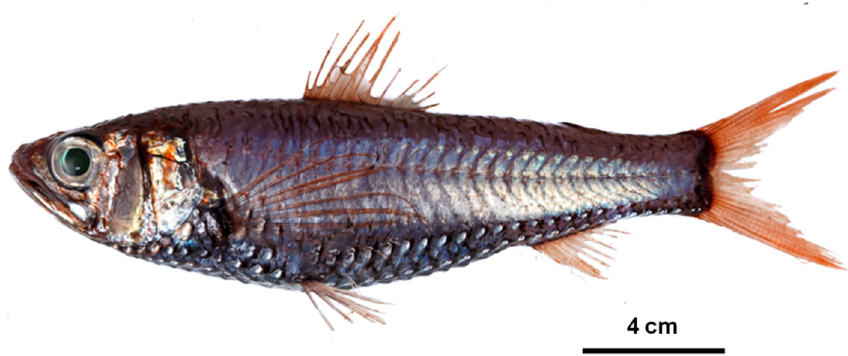
Figure 1. Neoscopelus microchir MHN USC 25200, 223.2 mm TL, caught in the Porcupine Bank, south-western Ireland (Photo: Francisco Baldó).